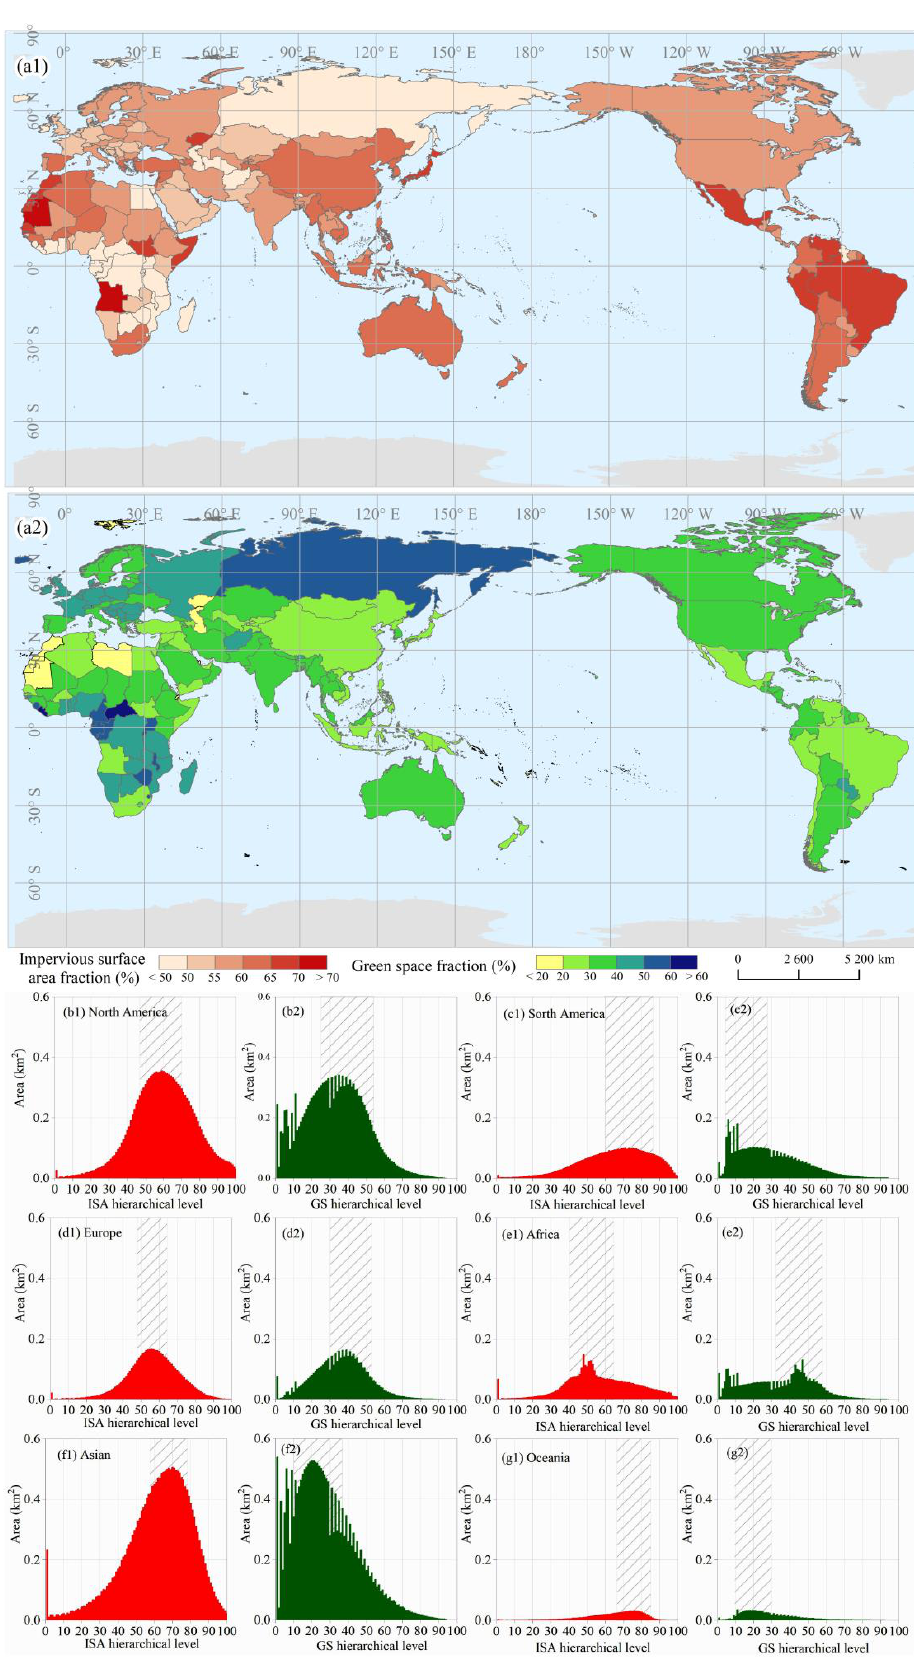
Figure 7. Spatial distribution of global ISA ( a1 ) and GS ( a2 ) circa 2020. ( b1 , c1 , d1 , e1 , f1 , g1 ) show the areas of ISA in different regions; ( b2 , c2 , d2 , e2 , f2 , g2 ) show the areas of GS in different